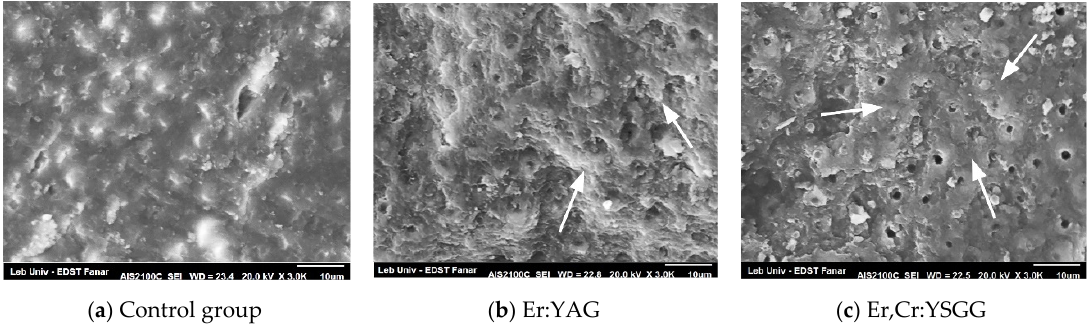
Figure 2. SEM observations of SBS test 24 h after bonding composite to deep dentin. ( a ) very little of resin left, absence of visible dentinal tubules probably due to the presence of smear layer. ( b , c ) Composite remnant in the intertubular dentin (arrows) with less intratubular infiltration.